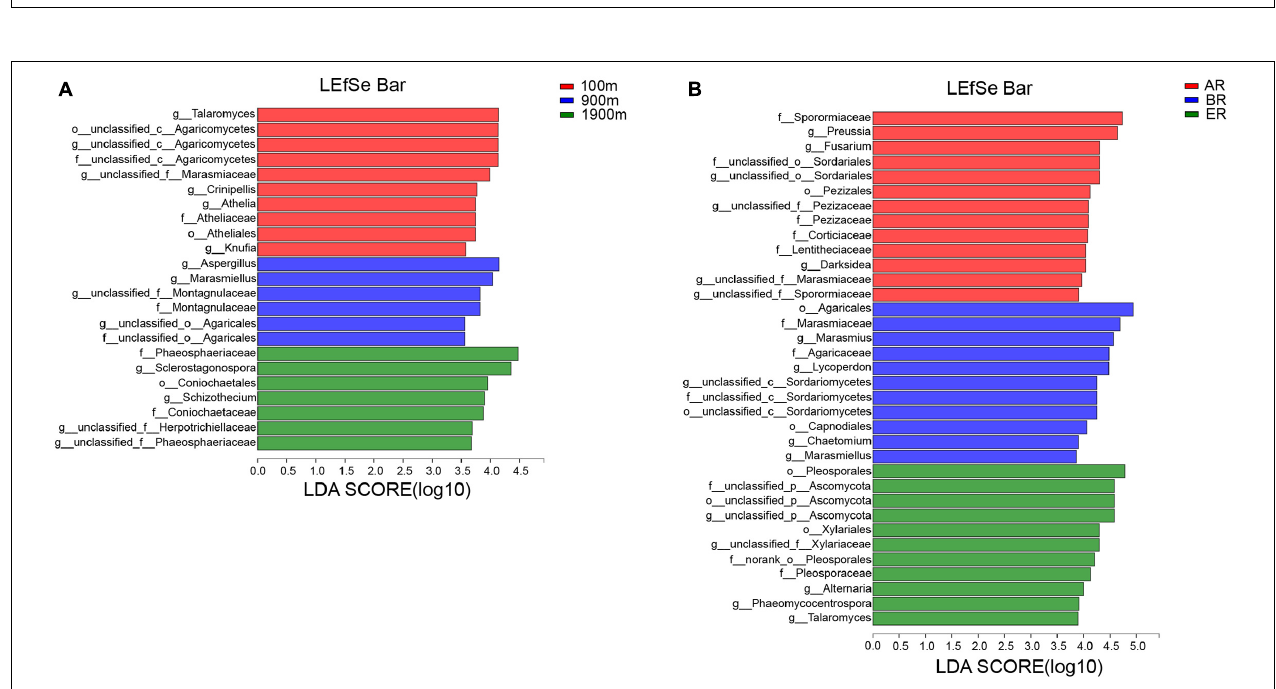
FIGURE 5 | Indicator fungi with LDA scores of 3.5 or greater in fungal communities associated with different distances (A) and routes (B) .